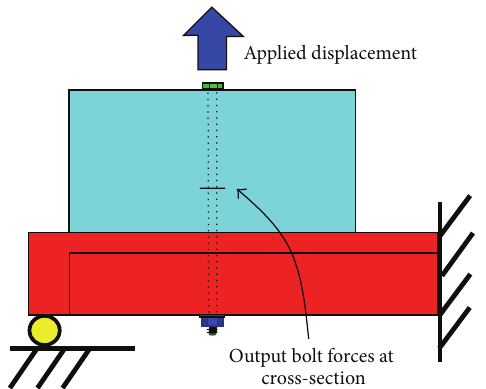
Figure 7: Schematic of axial force measurement location for detailed static tension